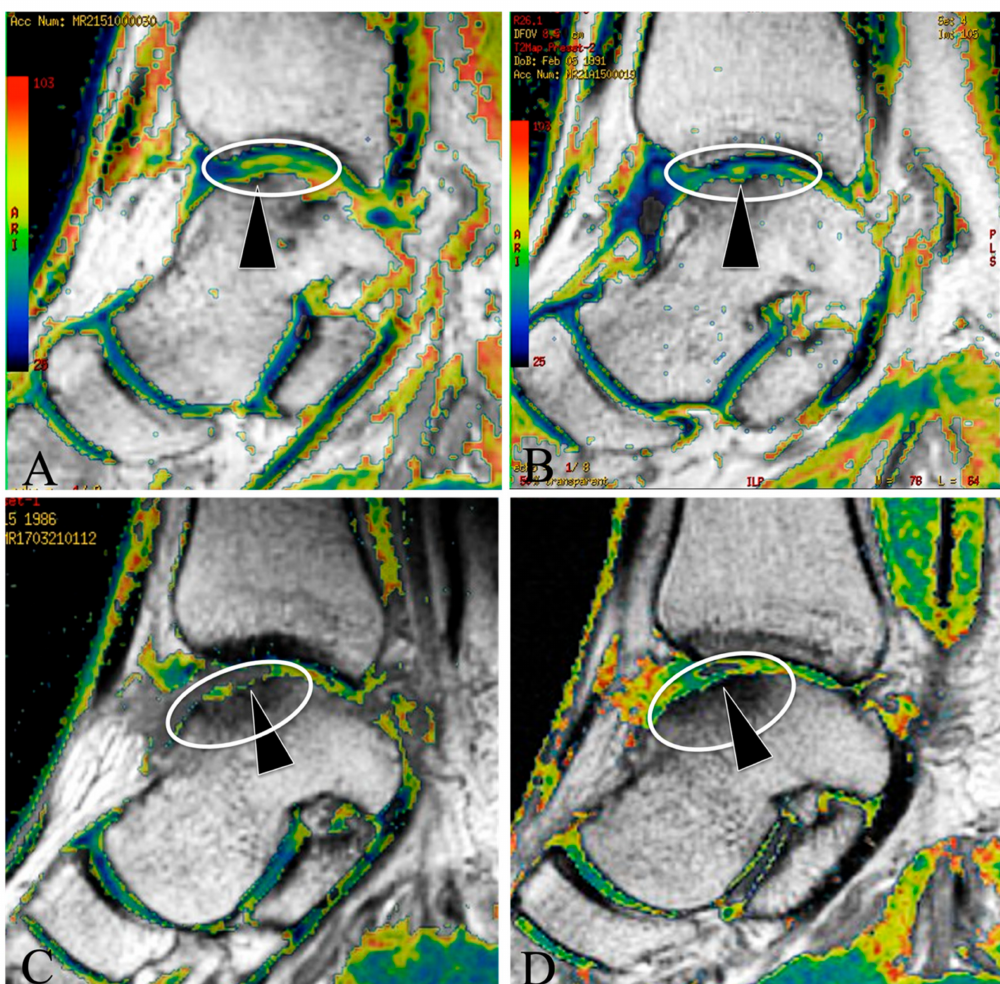
Figure 2. MRI T2 mapping assessment on the cartilage quality in MF + ESWT and MF + PRP groups at baseline and 2y follow up ( A ) baseline T2 mapping for OLT patients in the MF + ESWT group, the ellipse showed an OLT area (yellow-green, high T2 mapping value), and the arrow showed an osteochondral lesion in a patient; ( B ) T2 mapping for the MF + ESWT group at 2y follow up, the ellipse showed the regenerated cartilage (blue-green, lower T2 mapping value) in the same OLT patient at 2y follow up, and the arrow showed the osteochondral lesion had been refilled with neo-cartilage tissue; ( C ) baseline T2 mapping for OLT patients in the MF + PRP group, the ellipse showed an OLT area (yellow, high T2 mapping value), and the arrow showed a cartilage defect in a patient; ( D ) T2 mapping for the MF + PRP group at 2y follow up, the ellipse showed immature regenerated cartilage (green-yellow, slightly lower T2 mapping value) in the same OLT patient at 2y follow up, and the arrow showed the osteochondral lesion had been refilled with immature neocartilage tissue. Table 4. Multiple linear-regression analysis for the T2 mapping value of regenerated cartilage of OLT. Parameters B SEM p -Value VIF Treatment −